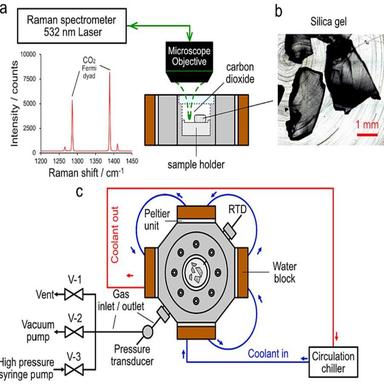
An overview of the Raman system used for direct measurements of adsorption of CO2 on silica gel or CH4 on ZIF-7. (a) High-resolution Raman spectroscopy in conjunction with a microscope and high-pressure visual cell (side view) is used to measure the CO2 density in the vapor phase (shown) and in the adsorbent material. (b) Optical image of the silica gel particles, showing their optical transparency. (c) Schematic overview of the experimental system, including the visual cell (top view).